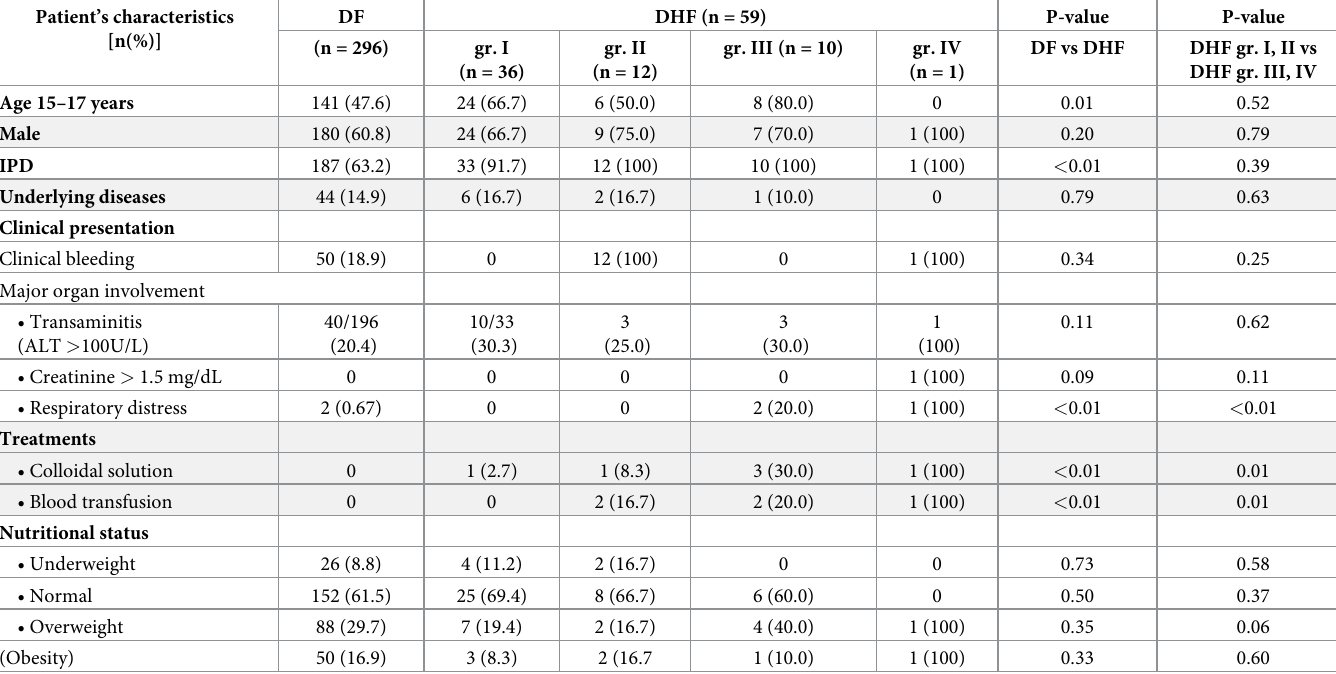
Table 2. Patient’s characteristics by 1997 WHO